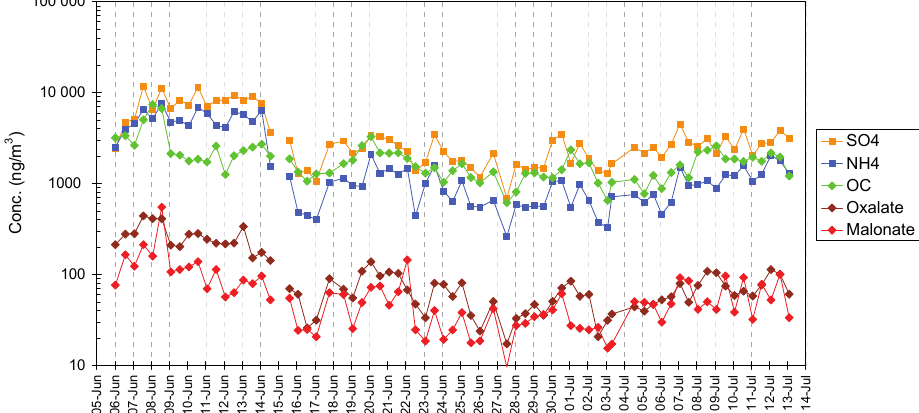
Figure 3. Time series for OC and selected ionic species, as derived from the PM2.5 front filters of the HVDS, in the 2007 summer campaign at Brasschaat. Fig. 3. Time series for OC and selected ionic species, as derived from the PM 2 . 5 front filters of the HVDS, in the 2007 summer campaign at